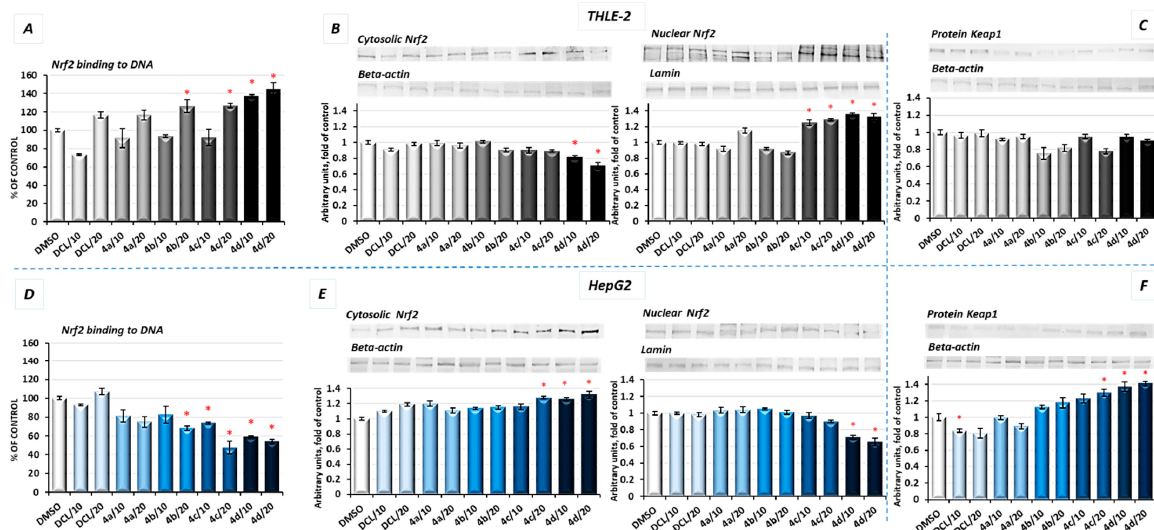
Figure 3. The effect of the DCL and DCL–OAO derivative conjugates ( 4a – 4d in 10 and 20 μ M concentrations) on the Nrf2– DNA binding capability, translocation from cytosol to nuclei, and Keap1 protein level in THLE ‐ 2 cells ( A – C ) and HepG2 cells, ( D – F ) after 24 h incubation. Activated Nrf2 was assessed in terms of the amount of Nrf2 contained in the DNA ‐ binding complexes extracted from the nuclear fraction ( A , D ). Data (mean ± SEM) from three separate experiments in comparison to control cells set to 100%. Representative immunoblots for the analysis of the cytosolic panels and nuclear ( B , E ) levels of the Nrf2 protein and cytosolic Keap1 protein ( C , F ) are shown. The sequence of the bands corresponds to the sequence of the bars in the graph. Lamin and β‐ actin were used as a loading control. The values were calculated as protein levels in comparison to control cells set to 100%. * Significantly different from control—DMSO ‐ treated cells, p < 0.05. Statistical significance was assessed by Student’s t ‐ test.